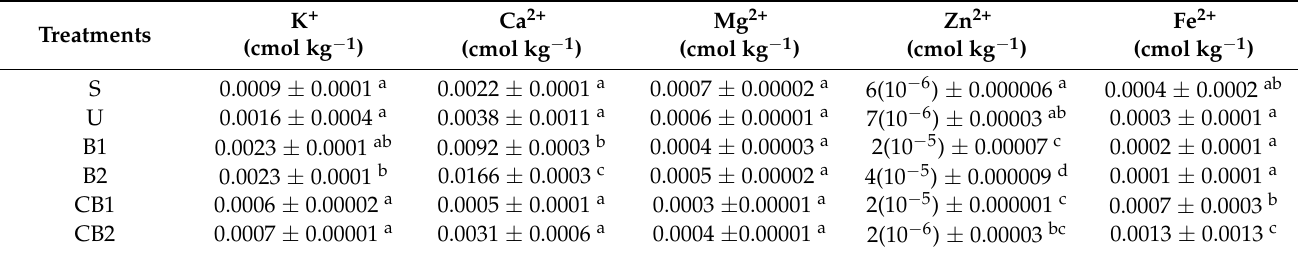
Table 8. Effects of rice straw biochar on selected soil cations of pot